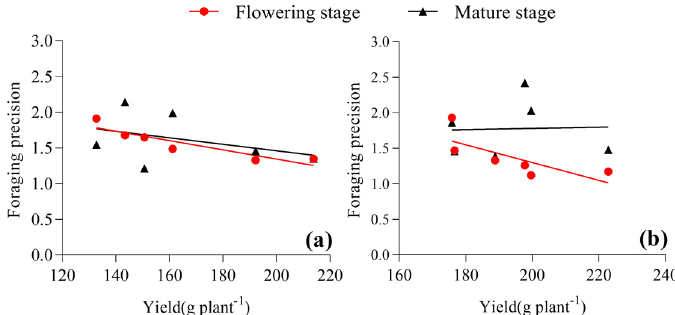
Figure 9. Relationship between maize yield and ( a ) Intraspecific competition (Flowering stage: r = − 0.909, p = 0.011; Mature stage: r = − 0.385, p = 0.450), ( b ) No competition (Flowering stage: r = − 0.742, r = − 0.742, p = 0.091; Mature stage: r = 0.036, p = p = 0.091; Mature stage: r = 0.036, p = 0.945).